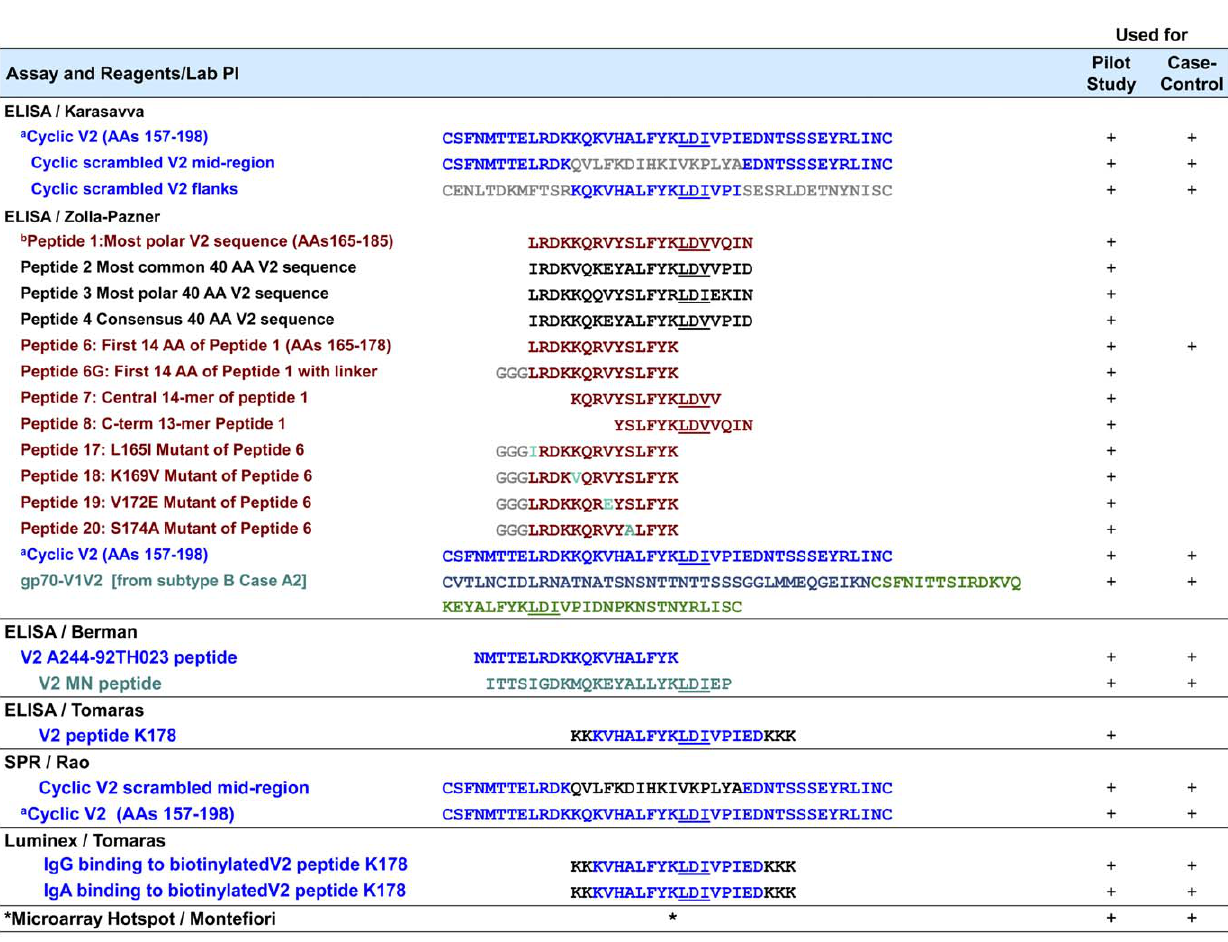
Figure 1. V2-related Reagents and Assays Used in the Pilot and Case-Control Analyses. The superscripts denote the following: a ‘‘Cyclic V2 (AAs 157–198)’’ was used in assays in three labs as shown. Throughout this table, blue V2 sequences are identical to the subtype E 92TH023 used in the prime; gray represent scrambled sequences or linkers; brown represents the sequence the central AAs in an extremely polar V2 in subtype A strain QB585.2102M.Ev1v5.C (http://www.hiv.lanl.gov) with individual mutations shown in cyan; black represents sequences chosen for particular properties, as described; green represents the V1V2 from subtype B Case A2 [20] and the central 23-mer of V2 from subtype B strain MN. b All peptides were biotinylated at the N-terminus with the exception of peptide K178 and peptide V2 A244-92TH023 which were biotinylated at the C- terminus. * Multiple V2 peptides from various strains (see text).